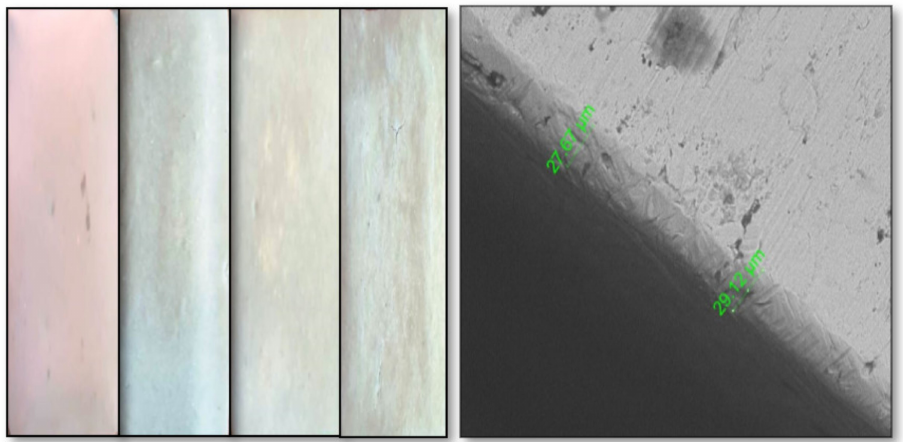
Figure 2. Optical photographs of the composite coating with DPET/PMMA-reinforced Al 2 O 3 nanoparticles on a low-carbon substrate, and the coating thickness.